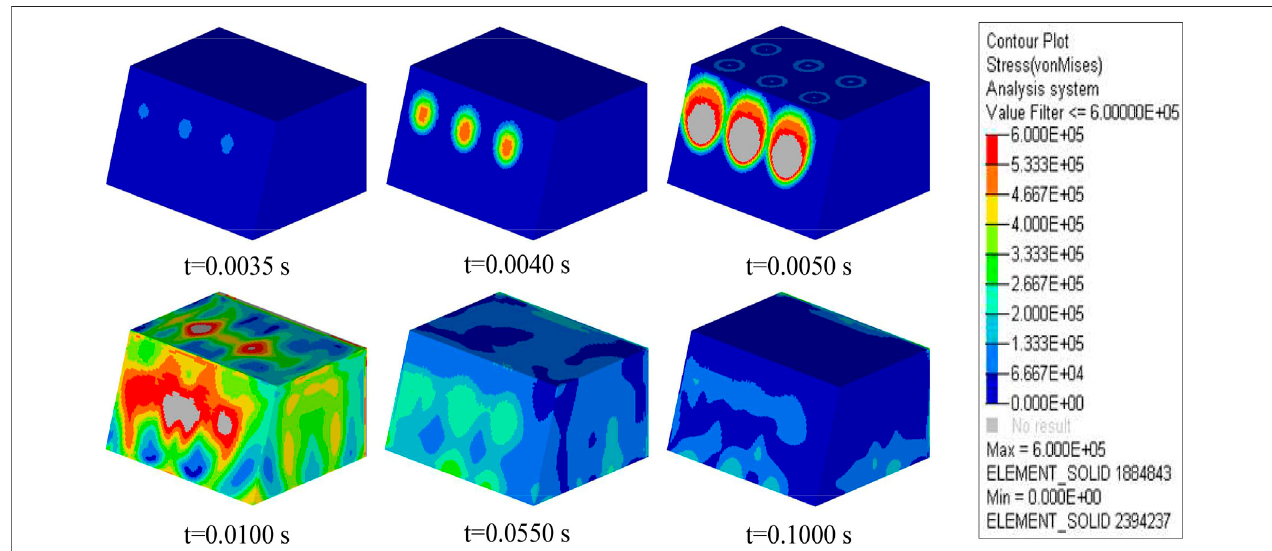
FIGURE 5 | Cloud diagram of initial stress distribution at the speci fi ed time steps.